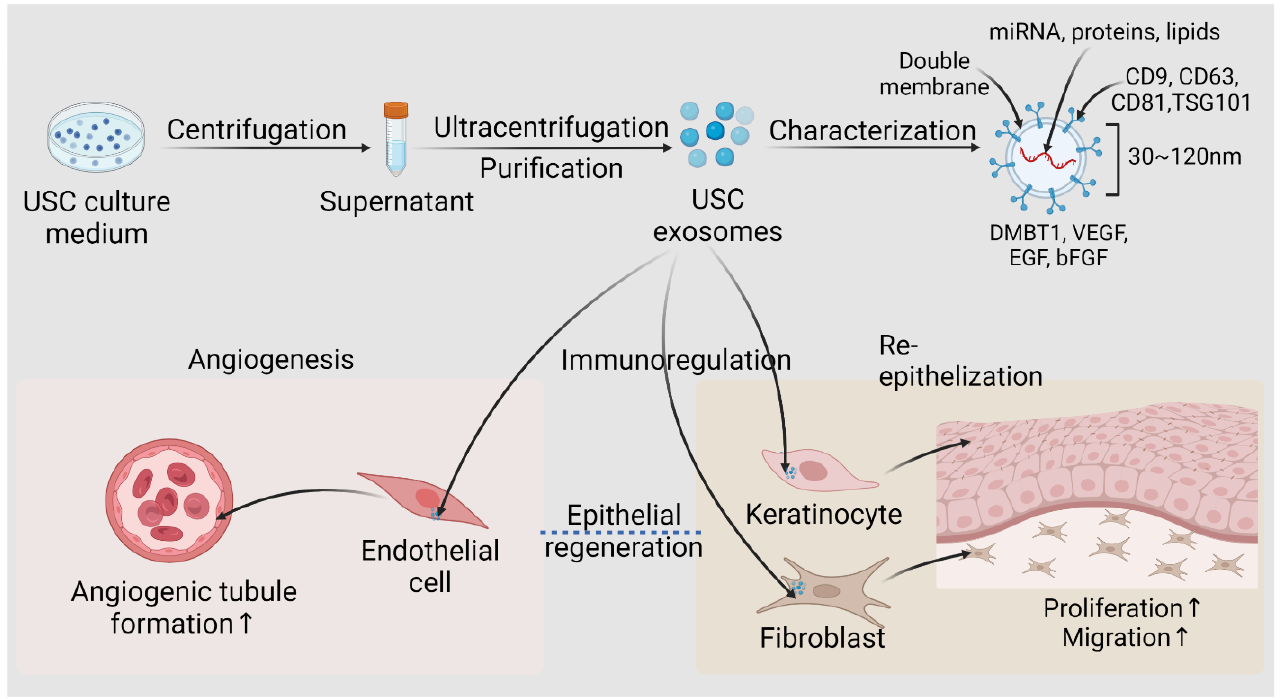
Figure 8. Isolation, characterization, and roles of USC-exosomes in epithelial regeneration. USC generates abundant exosomes, which are 30–120 nm-sized vesicles with lipid bilayer membrane harboring molecules such as miRNA, protein, and lipids. Exosomes are secreted extracellularly and exert angiogenic, immunoregulatory, or trophic effects on the surrounding microenvironments. Urine-derived stem cell; DMBT1, deleted in malignant brain tumors 1; VEGF, vascular endothelial growth factor; TGF- β 1, transforming growth factor- β 1; EGF, epidermal growth factor; bFGF, basic fibroblast growth factor; ↑ indicating increase. Created with BioRender.com accessed on 27 July